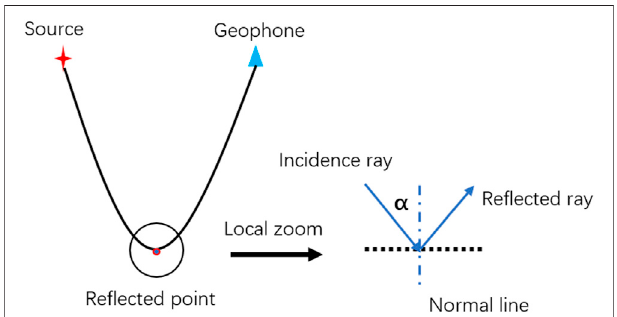
FIGURE 1 | Schematic illustration of incident wave and re fl ected wave. And α is the incident angle.